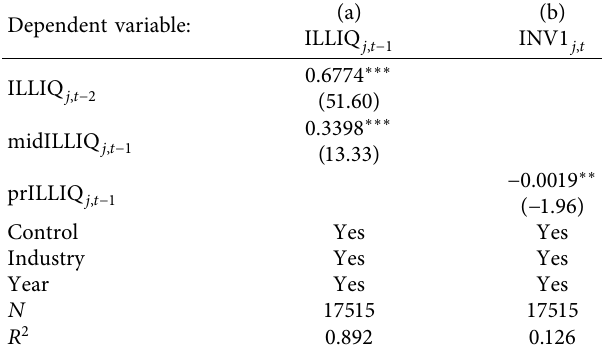
Table 4: Two-stage least-square